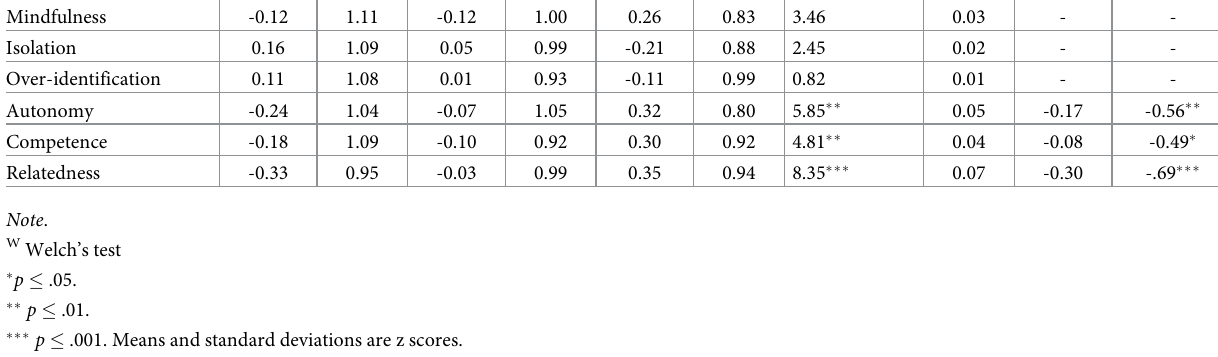
Table 4. ANOVA comparing the participants’ scores on self-compassion and self-determination according to their level of post-traumatic growth. Predictive variables Self-kindness